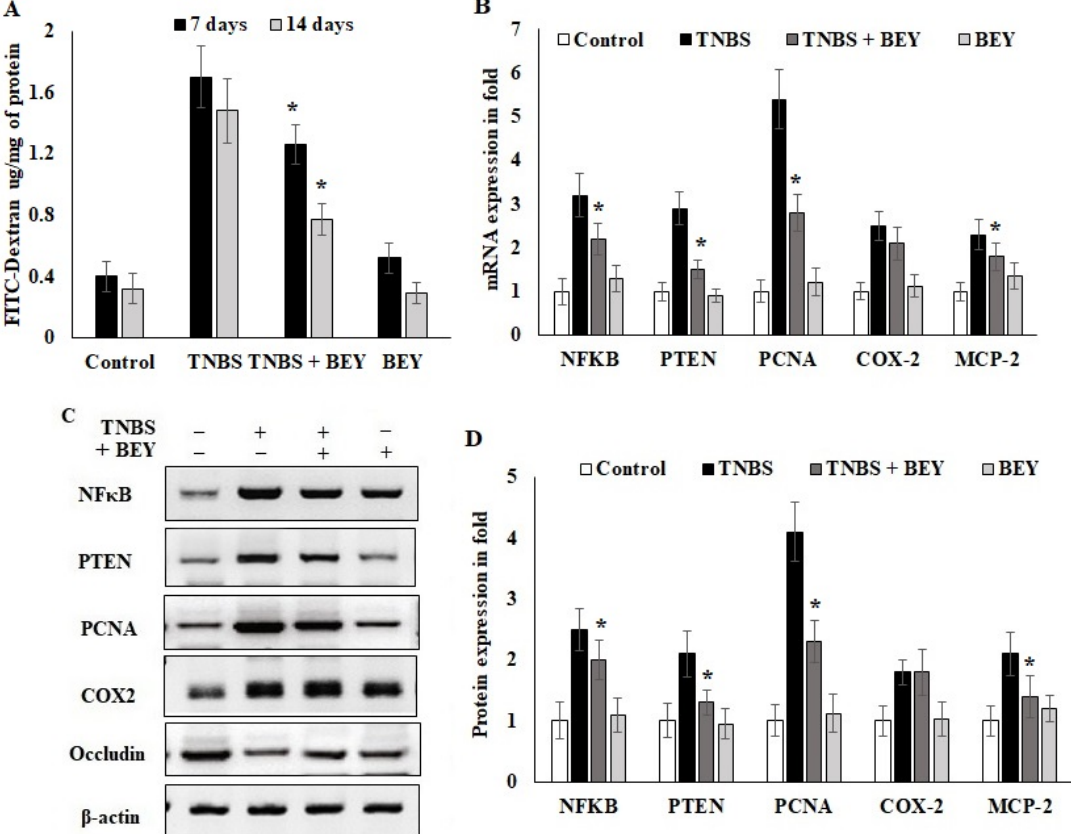
Figure 4. Effect of Bacillus on TNBS-induced colitis. Bacillus enhanced the intestinal barrier function of colitis mice by regulating inflammatory markers. ( A ) Detection of FITC-dextran in serum of mice by fluorometric ELISA. ( B ) qPCR of NF κ B, PTEN, PCNA, COX-2 and occludin mRNA in colonic tissues on the 14th day of TNBS-induced mice (all values were normalized to the TNBS-induced group). ( C , D ) Immunoblot and densitometric analysis of NF κ B, PTEN, PCNA, COX-2 and occludin protein expression normalized with actin internal control. Data are representative of at least three independent experiments. Data are shown as mean ± SD of the mean ( n = 3). * p < 0.05 represents significance compared to the TNBS vs. TNBS + BEY